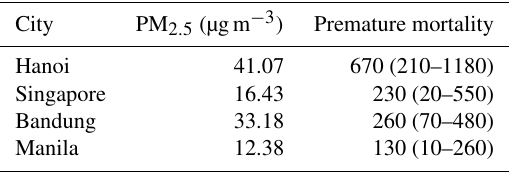
Table 7. Updated PM 2 . 5 concentration (µgm − 3 ) and premature mortality (95% confidence intervals) in Hanoi, Singapore, Ban- dung, and Manila with missing anthropogenic aerosol components.